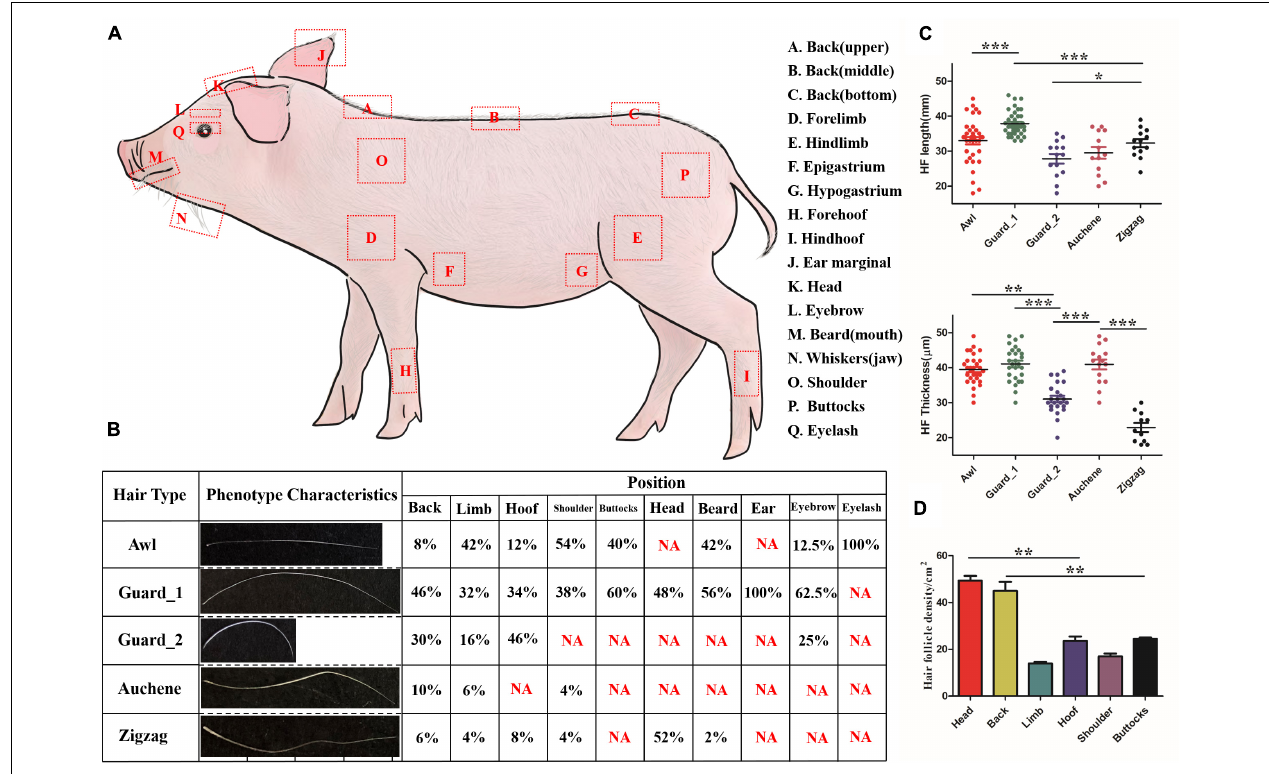
FIGURE 1 | Characteristics of different hair types in pig. (A) Diagram illustrating the locations on the body where different hair type samples were obtained. (B) Five different hair types found on different body parts of pig; NA, not this hair type. (C) Quantification of HF length (upper panel) and HF thickness (lower panel). (D) Quantification of HF in different pig body parts. Each body part with three biological replications. * p < 0.05; ** p < 0.01; *** p < 0.001.